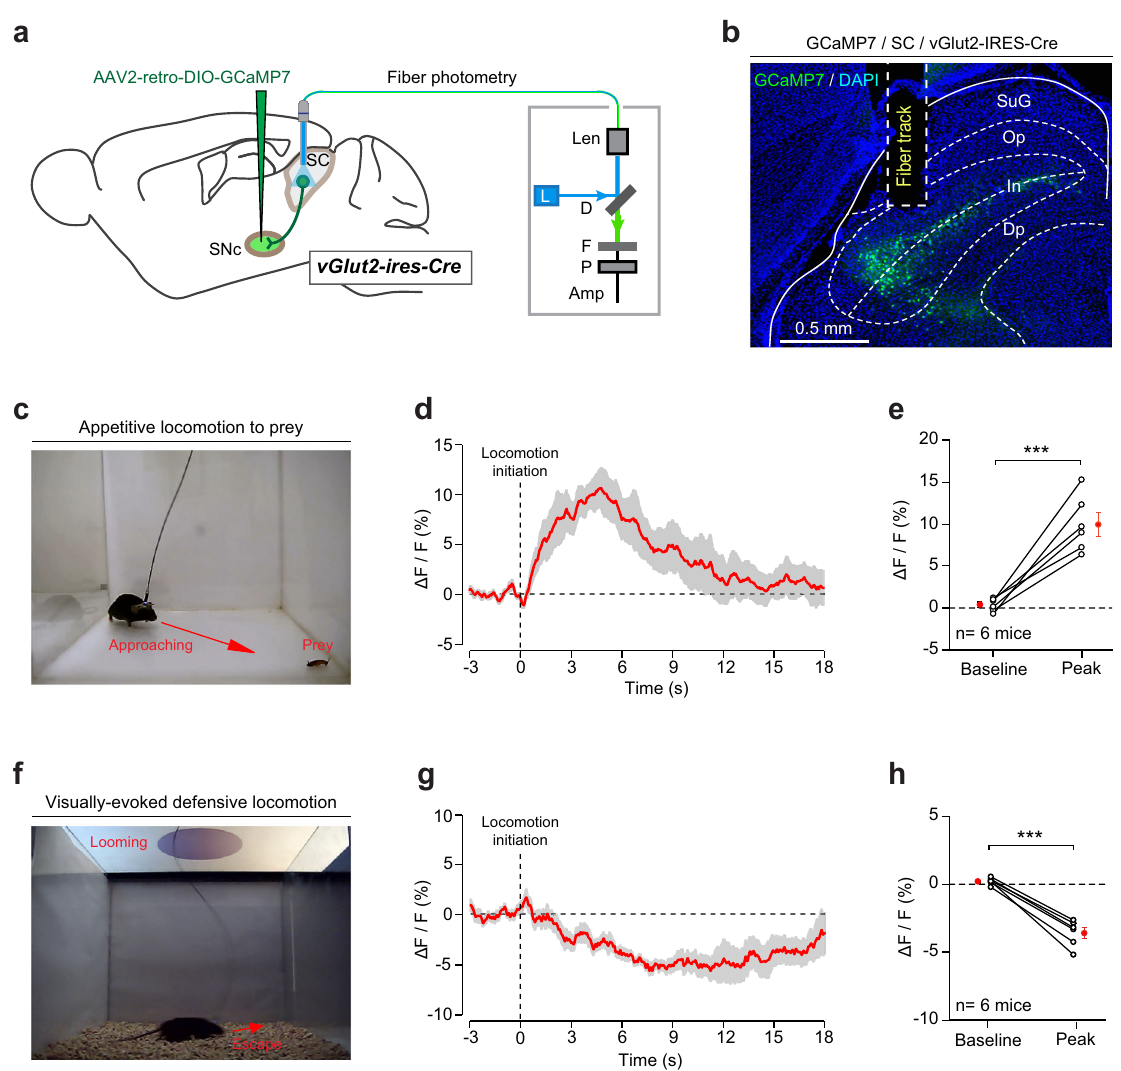
Fig. 5 SNc-projecting SC neurons are selectively recruited during appetitive locomotion. a Schematic diagram showing fi ber photometry recording from SNc-projecting SC neurons. b An example micrograph showing optical- fi ber track above the SNc-projecting SC neurons that expressed GCaMP7. This experiment was repeated independently in six mice with similar results. c , f Example pictures showing fi ber photometry recording from SNc-projecting SC neurons when mice exhibit appetitive locomotion toward prey ( c ) or defensive locomotion away from looming visual stimuli ( f ). d , g Time courses of normalized GCaMP fl uorescence of SNc-projecting SC neurons of an example mouse before and during appetitive locomotion toward prey ( d ) or defensive locomotion away from looming visual stimuli ( g ). e , h Quantitative analyses of GCaMP fl uorescence showing the SNc-projecting SC neurons were activated during appetitive locomotion toward prey ( e ) and inactivated during defensive locomotion away from looming visual stimuli ( h ). Scale bars are indicated in the graphs. Number of mice was indicated in the graphs ( e, h ). Data in d , e , g , h are means± SEM (error bars). Statistical analyses in e , h were performed by one-sided Student ’ s t -test (*** P <